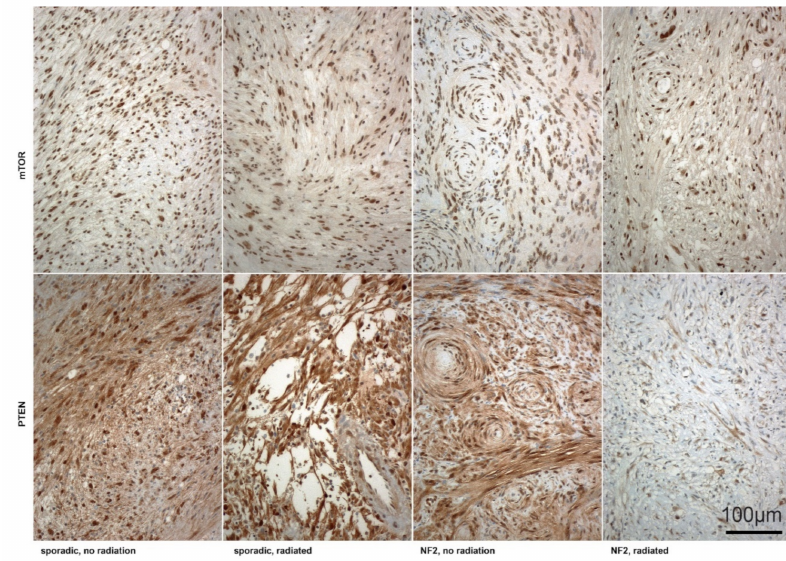
Figure 4. Immunostaining for mammalian target of rapamycin (mTOR) (upper row) and phosphatase and tensin homolog (PTEN) (lower row) in non-irradiated compared to irradiated VS in the two comparison groups (NF2 vs. sporadic). Scale bar = 100 µ